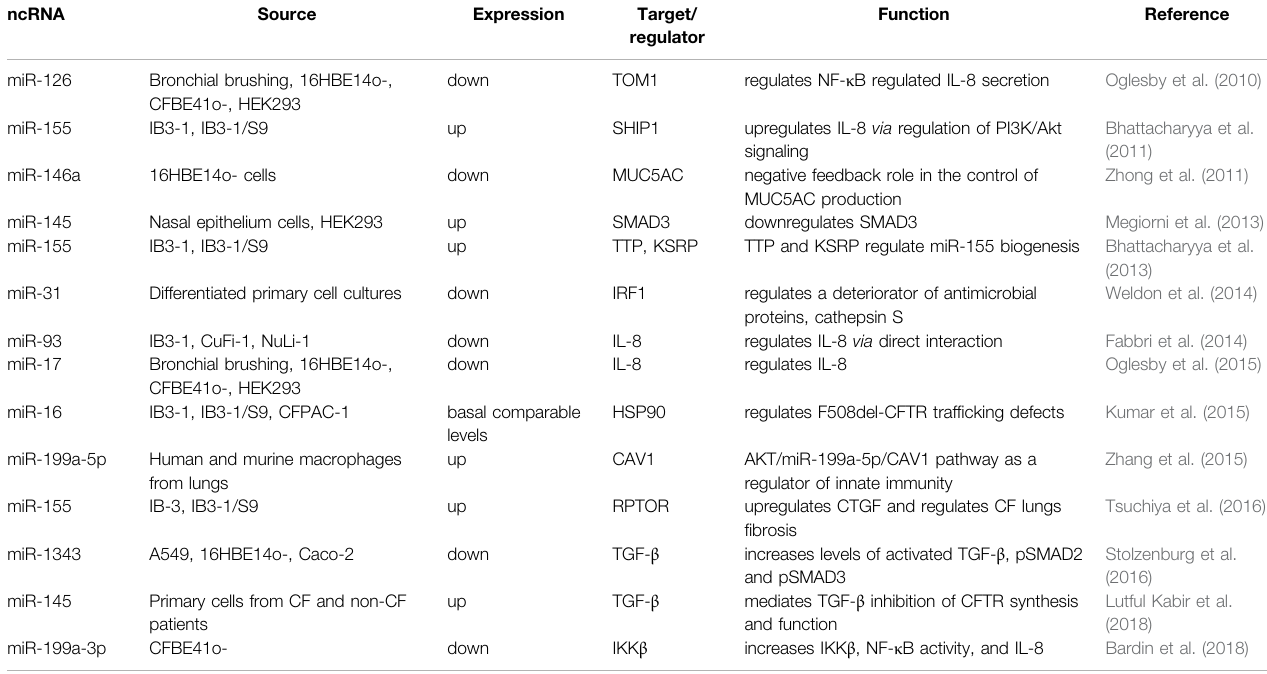
TABLE 4 | List of ncRNAs and their targets (other than CFTR) and functions in cystic fi brosis.